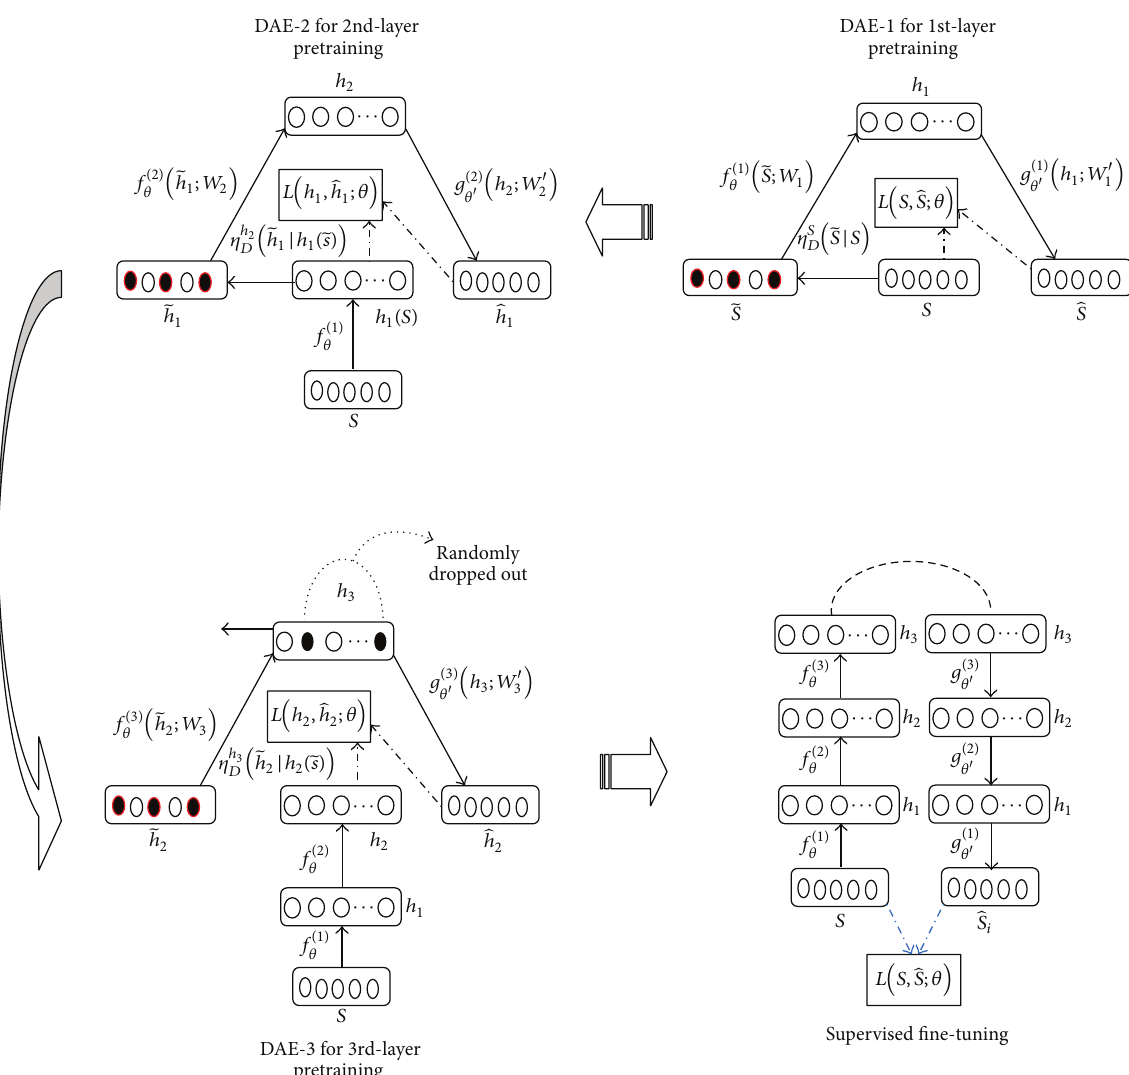
Figure 4: DAASM architecture and greedy learning procedure. Greedy layerwise pretraining procedure is depicted by counterclockwise flow in the